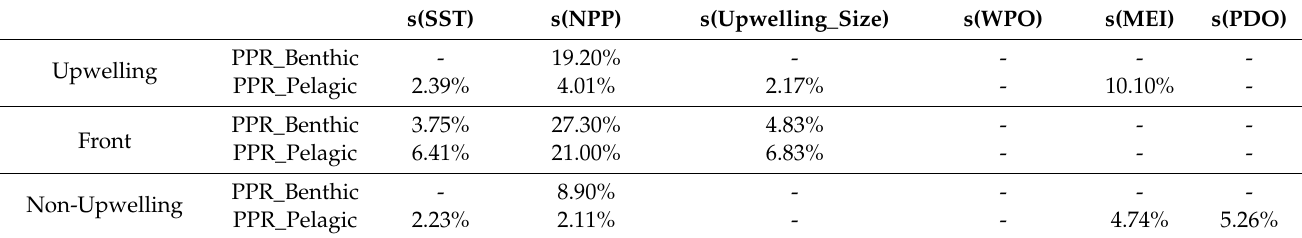
Table 3. The deviance explained by each factor in each habitat GAM